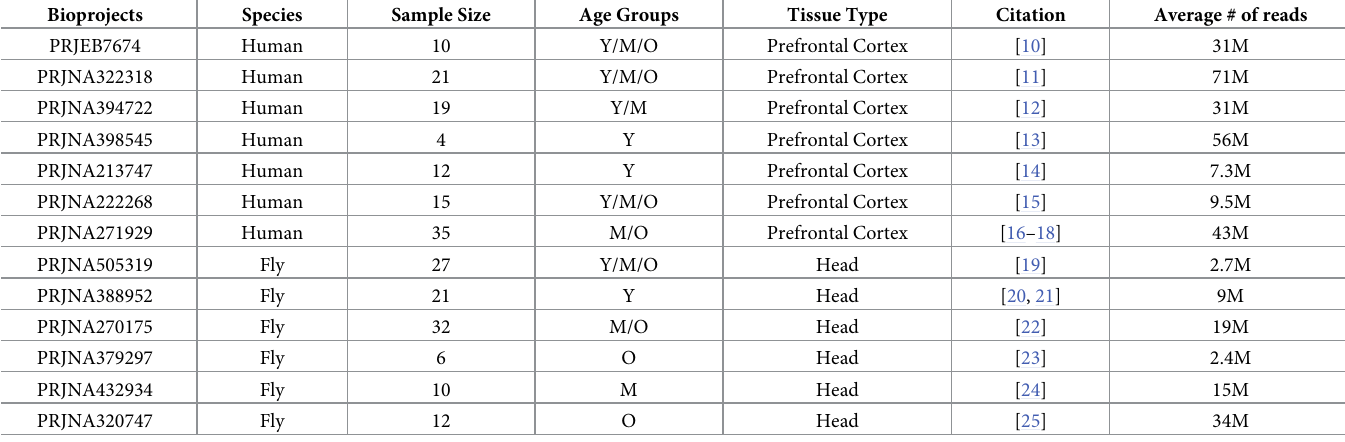
Age groups are abbreviated young (Y), middle (M) and old